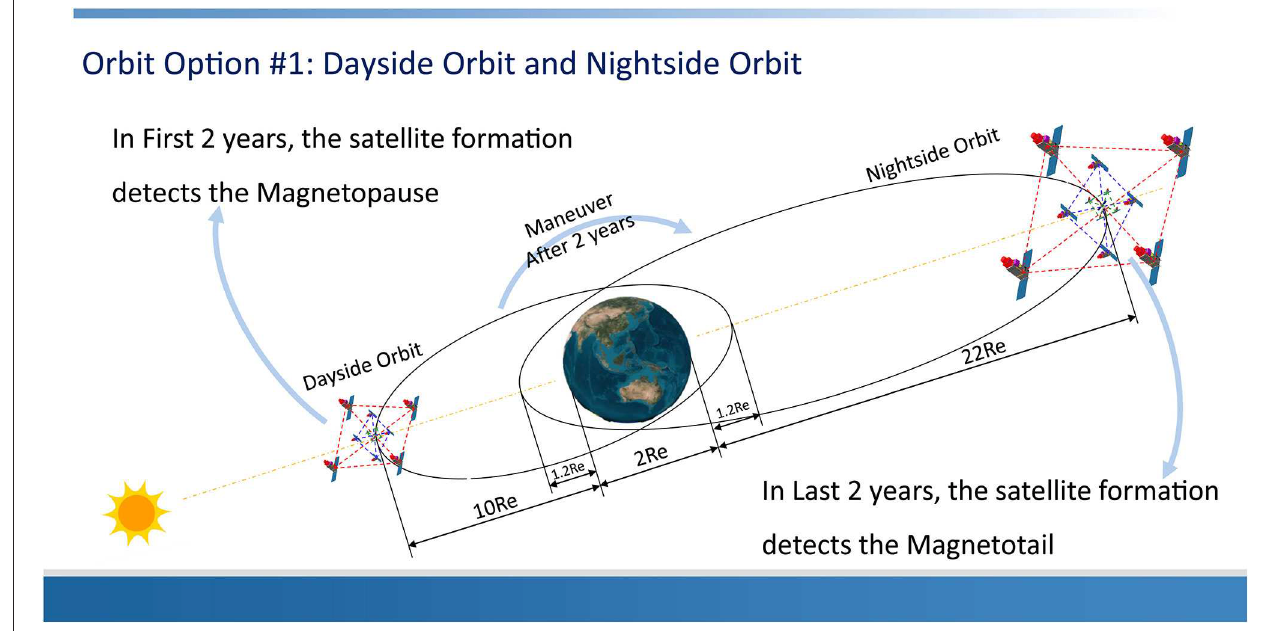
FIGURE 10 | The configuration of the spacecraft orbit in option # 1.